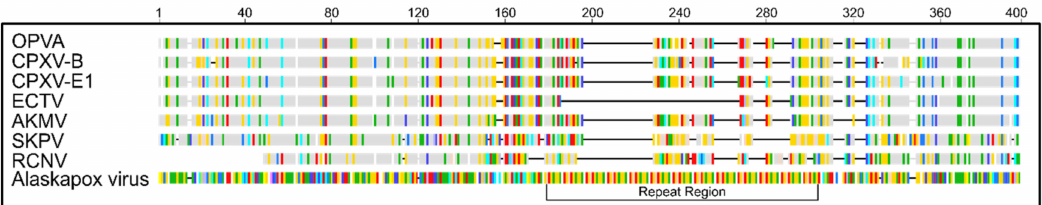
Figure 3. Comparison of predicted hemagglutinin protein from Alaskapox virus (AKPV) and reference OPXVs. Amino acid sequence of AKPV hemagglutinin is shown in RasMol color scheme. For others, amino acid sequence is colored compared to AKPV protein: identities are shown in gray; di ff erences are colored according to RasMol scheme. Gaps not shared with AKPV are shown by black horizontal lines. Sequences from OPVA, CPXV-B, CPXV-E1, ECTV-Moscow, AKMV-2013, SKPV, and RCNV-85A are